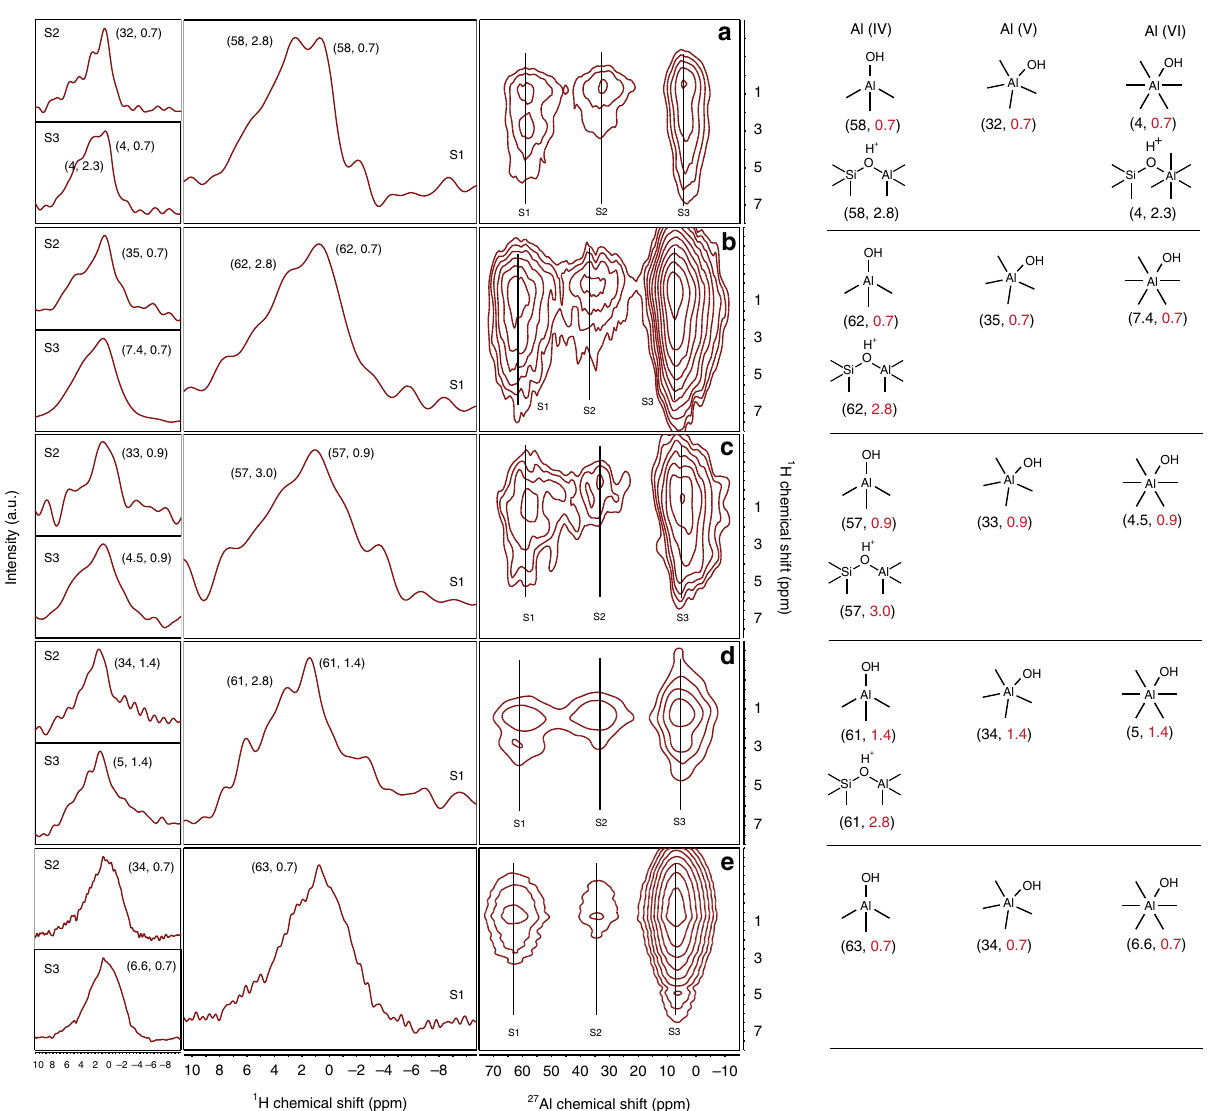
Fig. 7 DNP-enhanced 1 H- 27 Al HETCOR NMR spectra. a AC*-1.9, b AC-1.9, c AC-9, d AC-1.3, and e IP-0.3; slices of individual contours are shown on the left and proposed structures of Al sites are shown on the right. All spectra were acquired with a 12.0 kHz spinning frequency and a contact time of 0.4 1638 cm − 1 corresponds to pyridinium ions, indicating the binding of pyridine molecule with strong Brønsted sites.